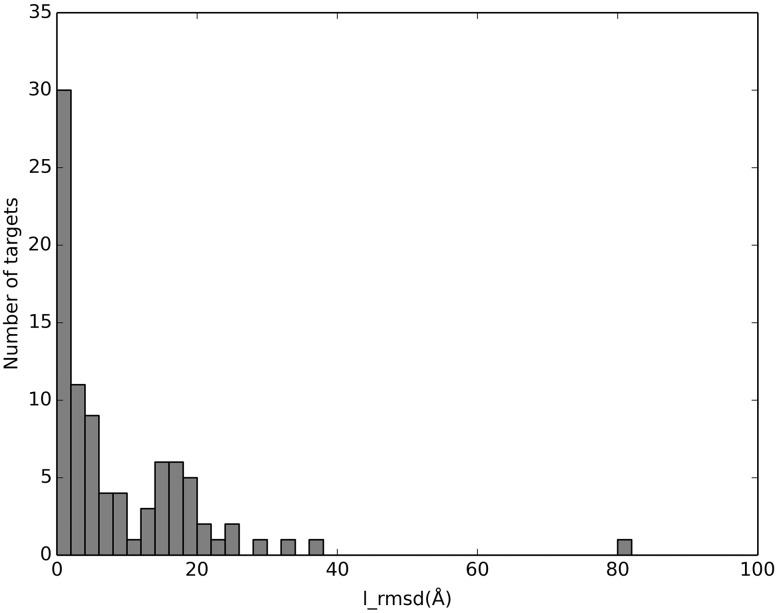
Distribution of best models of the complexes according to the ligand RMSD.